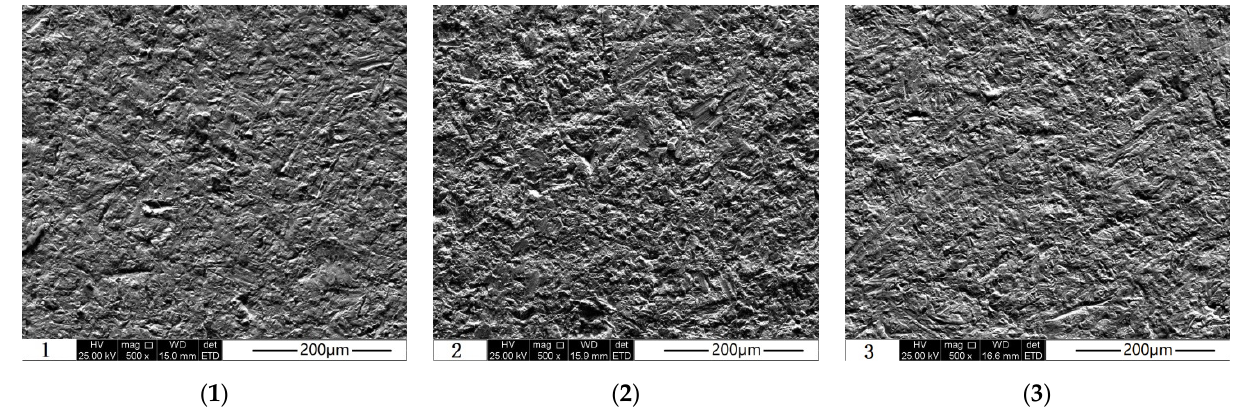
Figure 14. Erosion wear morphology, ( 1 ) High manganese steel, ( 2 ) Medium chromium alloy steel, ( 3 ) High chromium alloy steel.